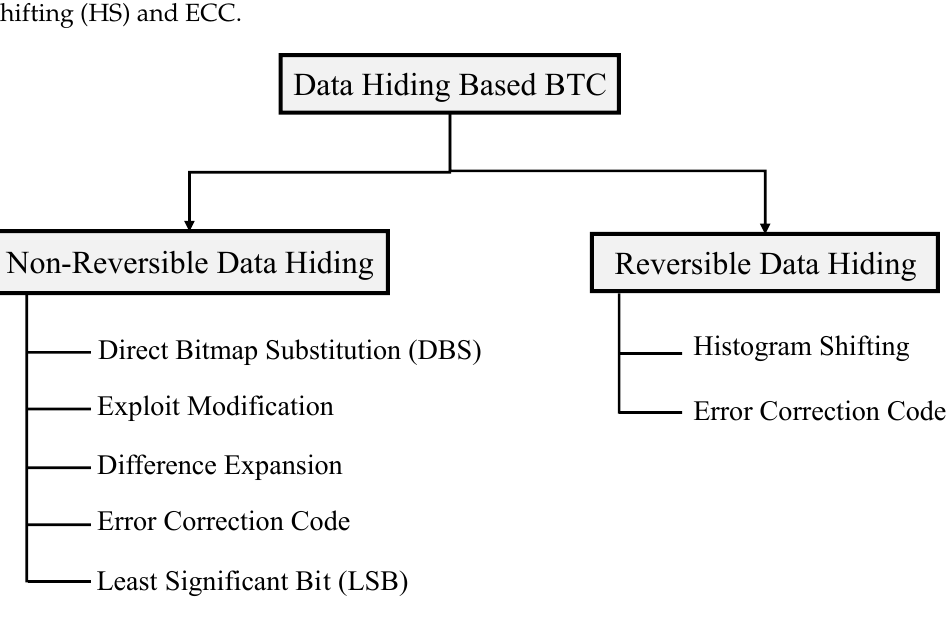
Figure 4. Classification of DH based on